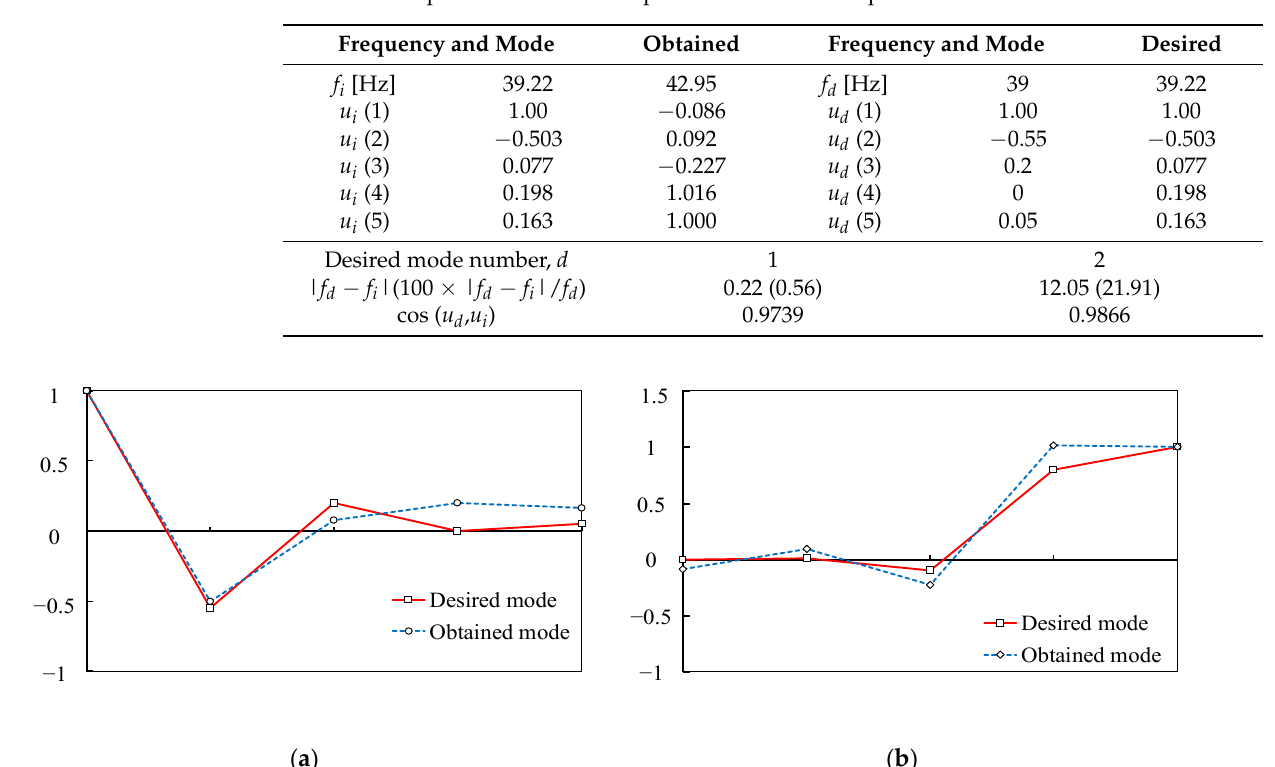
Table 16. Comparison of natural frequencies and mode shapes.